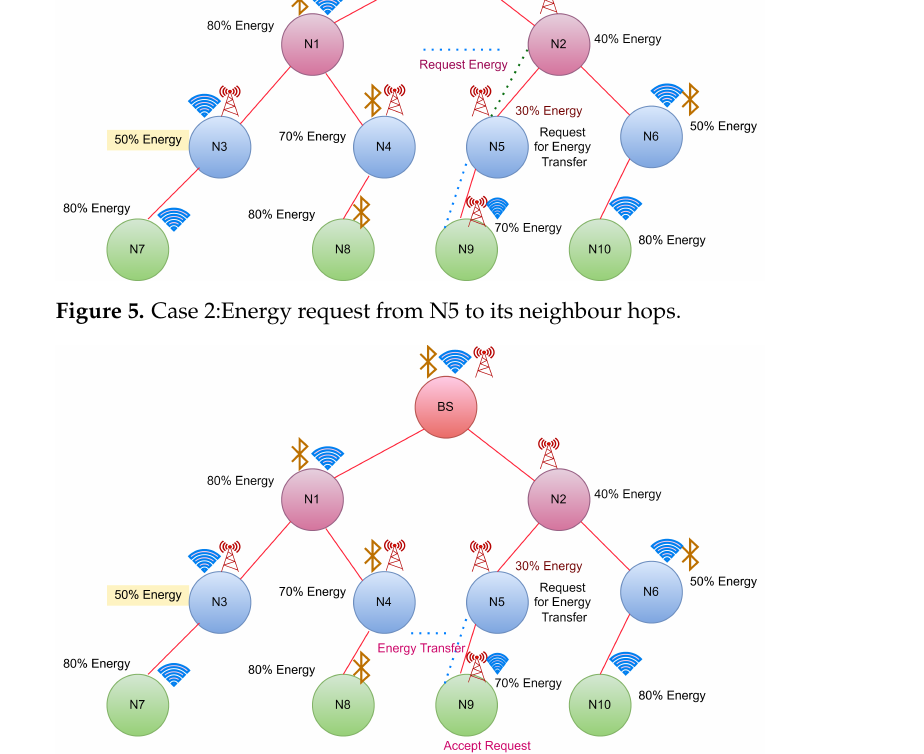
Figure 6. Case 2:Energy transfer from N9 to